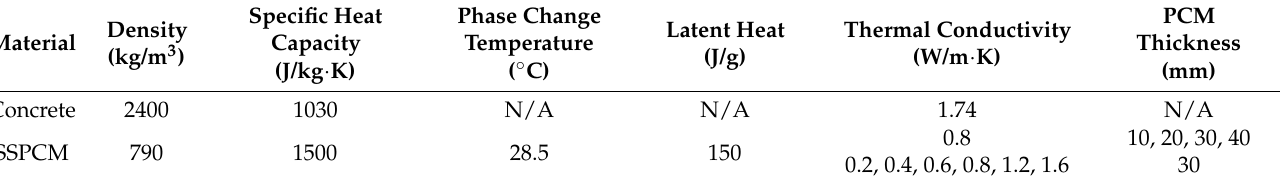
Figure 6. The heat transfer physical model of the granary walls.: ( left ) the SSPCM granary wall and ( right ) the common granary wall. Table 1. Material properties of concrete and SSPCM